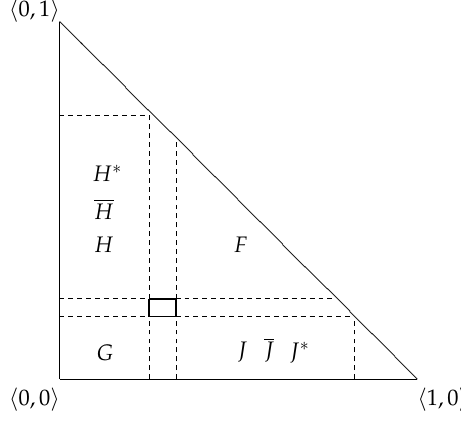
Figure 4. Region of transformation by the application of the Fig. 4. Region of transformation by the application of the operators